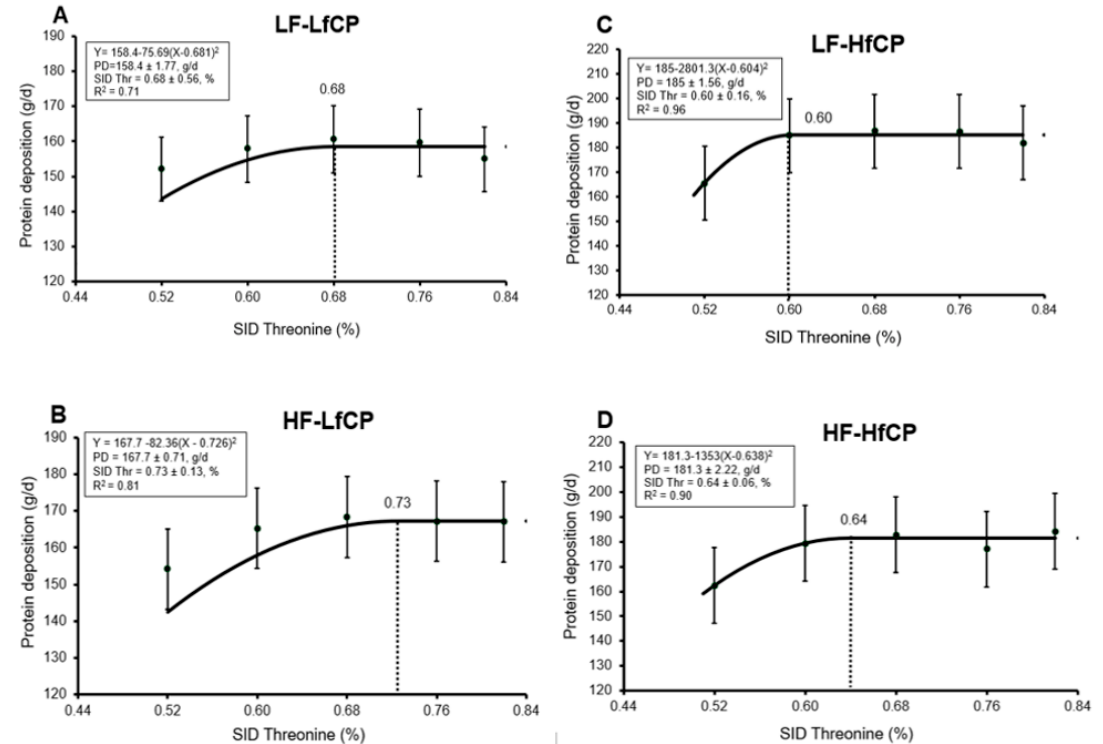
Figure 1. Quadratic breakpoint model analysis of threonine requirement in growing pigs fed a diet with low (LF) or high (HF) fibre content and low (LfCP) or high (HfCP) fermentable protein content ( n = 8 / treatment). The breakpoint estimate for LF-LfCP was 0.68% standardized ileal digestible (SID) Thr for maximum protein deposition (PD) of 158.4 g / d ( A ), HF-LfCP was 0.73% SID Thr for maximum PD of 167.7 g / d ( B ), LF-HfCP was 0.60% SID Thr for maximum PD of 185 g / d ( C ), and HF-HfCP was 0.64% SID Thr for maximum PD of 181 g / d ( D ). Each data point represents and average protein deposition value ( n = 8).